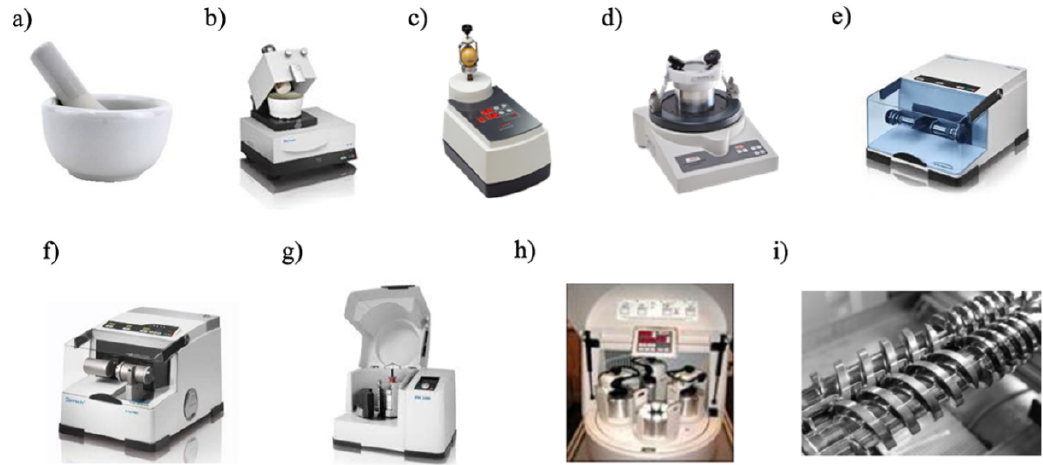
Figure 1. Common grinding and milling apparatus. ( a ) Mortar and pestle. ( b ) Automatic mortar (Retsch). ( c ) Vertical vibrational mini-mill (Fritsch). ( d ) Vibratory micro-mill (Fritsch). ( e ) Vibrational ball-milling (Retsch). ( f ) Vibrational ball-milling with temperature control (Retsch, Cryomill). ( g ) Planetary ball-milling (Retsch). ( h ) Multi-sample milling (Automaxion). ( i ) Twin-screw used for continuous mechanochemical processes. Reproduced with permission of the American Chemical Society from [17].